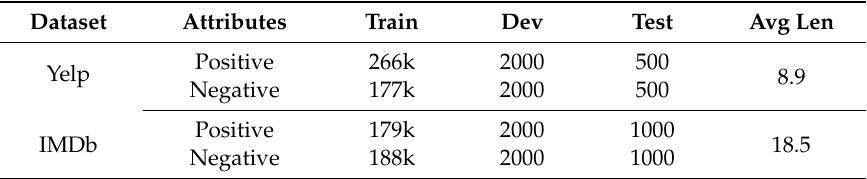
Table 1. The statistics of the Yelp and IMDb